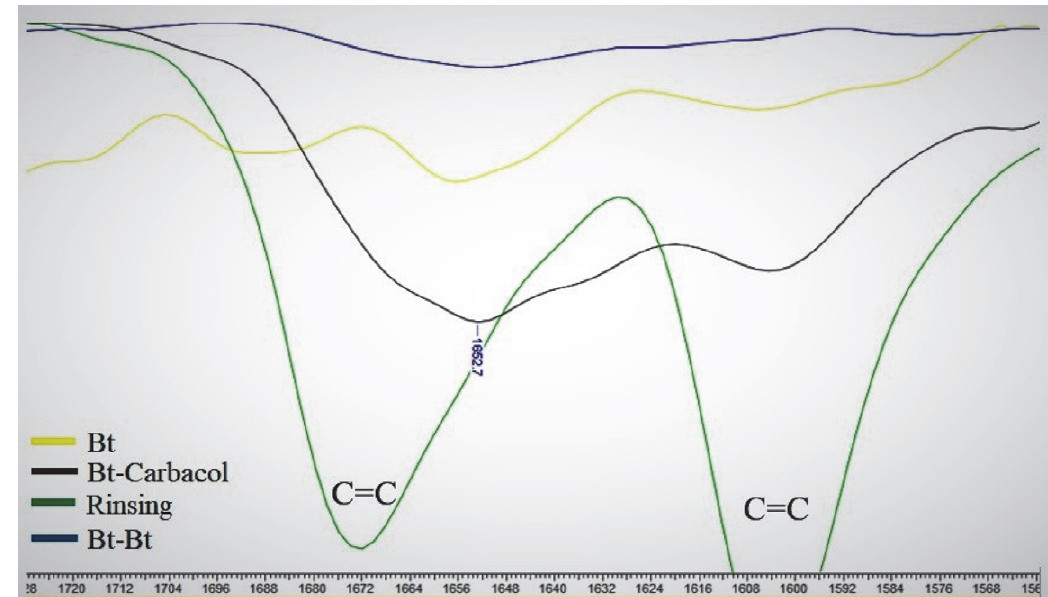
Figure 7. The peaks of carbazole disappear after the Bt-Bt matching at 1600 and 1672 cm –1